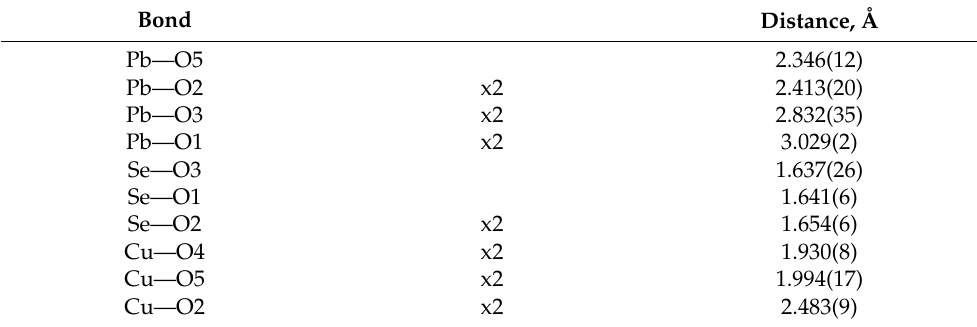
Table 2. Selected bond distances in the PbCu(SeO 4 )(OH) 2 crystal structure.